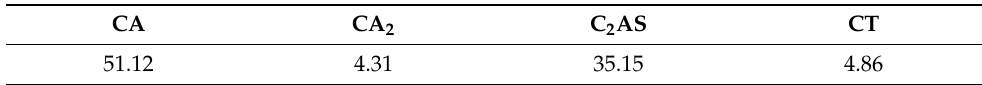
Table 2. Mineralogical composition of CAC (wt %).